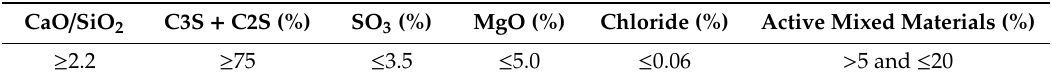
Table 1. Composition of